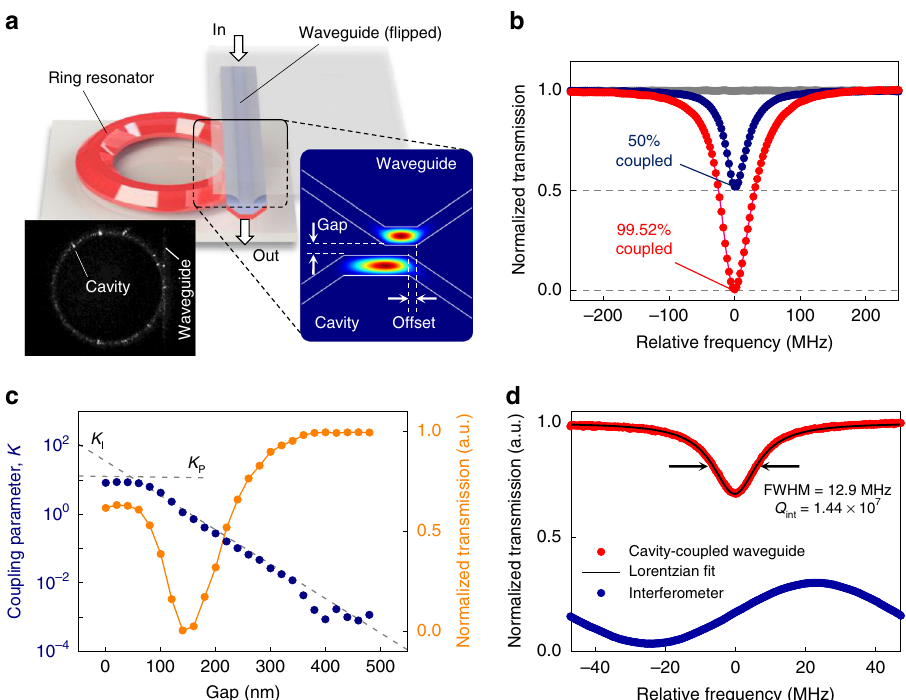
Fig. 2 Optical coupling between the trapezoidal waveguide and the ring resonator. a Schematic of the fl ip – chip coupling scheme. Optical modes in the waveguide and the resonator are evanescently coupled through their top surfaces. Coupling strength is controlled by adjusting the gap and the offset (inset, right). The left inset taken by IR camera shows the scattered light trace from the coupled chips. b Transmission spectra with different coupling strengths. c The gap versus coupling parameter K (navy curve) converted from the normalized transmission T (orange curve). The gap is obtained by monitoring the position of the piezo stage. When waveguide transmission was signi fi cantly dropped, the gap is determined to 0 nm. d Transmission spectrum for measuring Q -factor of the trapezoidal resonator (red curve) and its Lorentzian fi tting (black line). Intrinsic Q -factor of 14.4 million is obtained from the spectrum. The navy curve is the calibration spectrum from a fi ber Mach – Zehnder